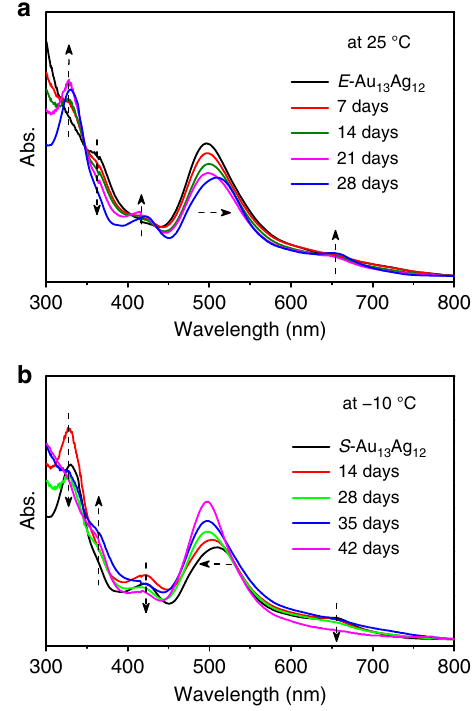
Fig. 5 UV-vis spectral evolution for the isomeric transformation of the nanoclusters. a E -Au 13 Ag 12 conversion to S -Au 13 Ag 12 at 25 °C. b The as-obtained S -Au 13 Ag 12 conversion to E -Au 13 Ag 12 at − 10 °C.